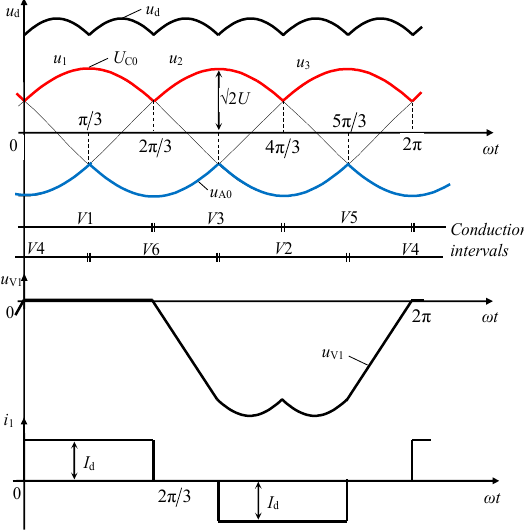
Figure 2. Typical waveforms of the mathematical model of a three-phase uncontrolled rectifier.